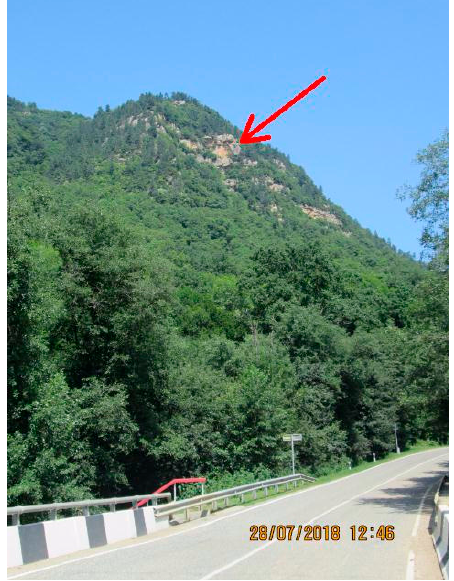
Figure 3. The Monakh Mountain geosite showing cliffs (red arrow) sculptured partly by huge block detachment after small historical and recent earthquakes (photo by D.A. Ruban).